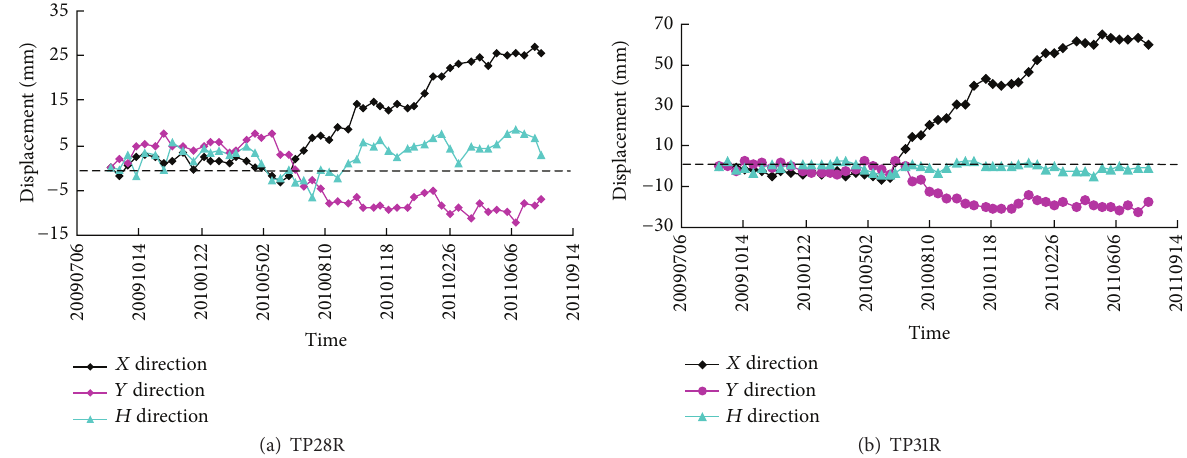
Figure 6: Accumulative displacement curves of the monitoring points TP28R and TP31R.